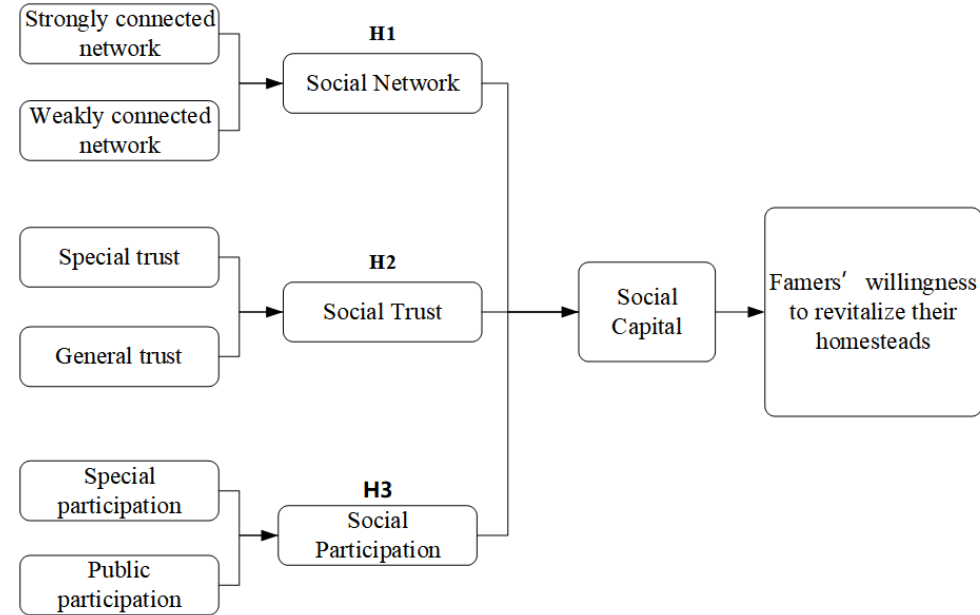
Figure 1. Theoretical analysis framework